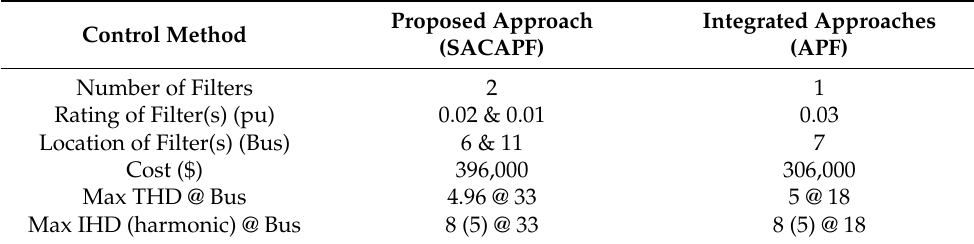
Table 7. Results of allocation of active filters in 33-bus IEEE network.